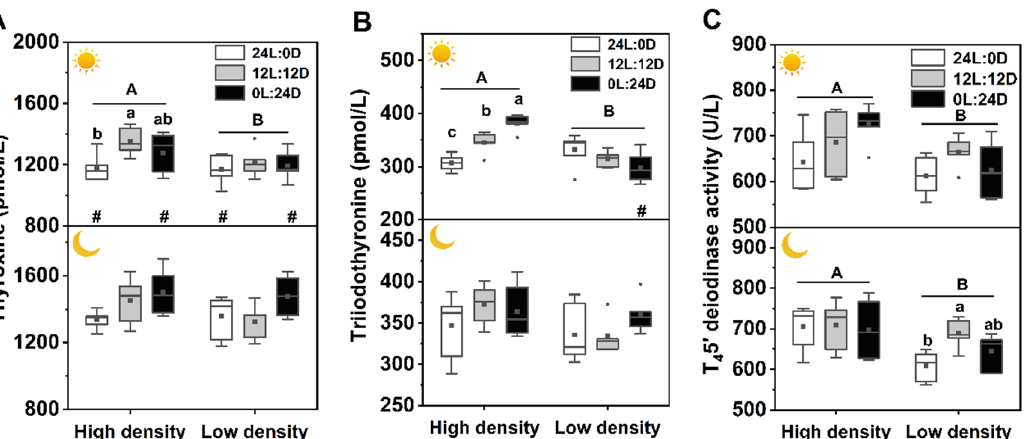
Figure 6. Effects of photoperiod and density on plasma T 4 ( A ), T 3 ( B ), and T 4 5 ′ -deiodinase activity ( C ) of Pelodiscus sinensis . and indicate daytime and nighttime, respectively. Data are n = 5 or 6 for all groups. Data are presented as the mean ± S.E. The description of the box plots is the same as that shown in Figure 1. Different lowercase letters denote statistically significant differences among different photoperiods under each density; different capital letters indicate a significant difference between different densities; # indicate a significant difference between the daytime and nighttime ( p <